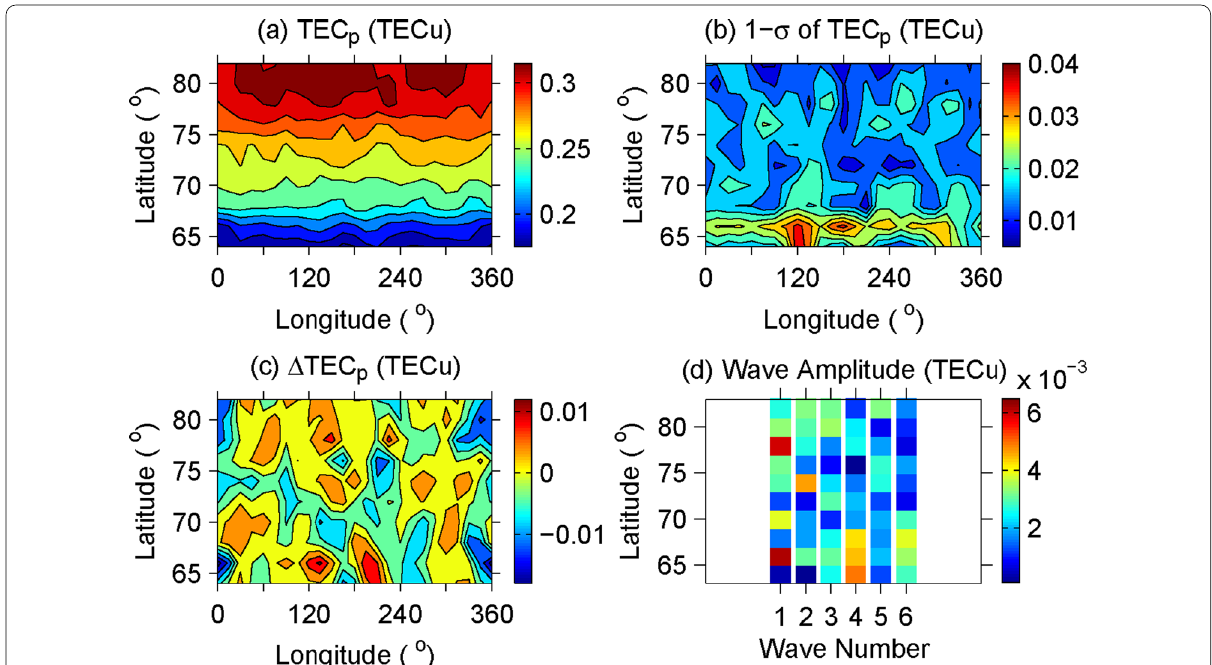
Fig. 7 Longitude and latitude variations and amplitudes of longitude wave components of TEC p . a Presents the gridded mean TEC p ; b is the standard deviation of the gridded TEC p ; c shows the residual TEC p after removing zonal averages; d presents the amplitudes of the longitude wave 1 to 6 of the residual TEC − −